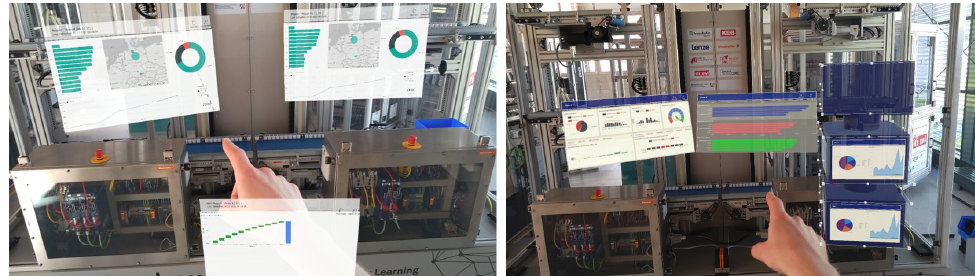
Figure 8. Left : View of the Microsoft PowerBI Toolbelt application; Right : View of the rotatable